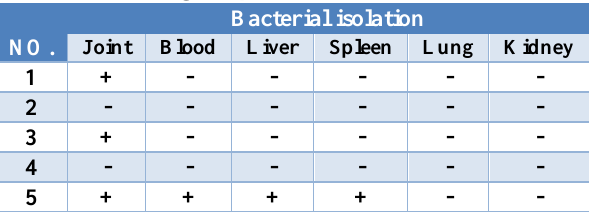
Table,2: Bacterial isolation from the blood, joint and internal organs of the 2st (immunized)